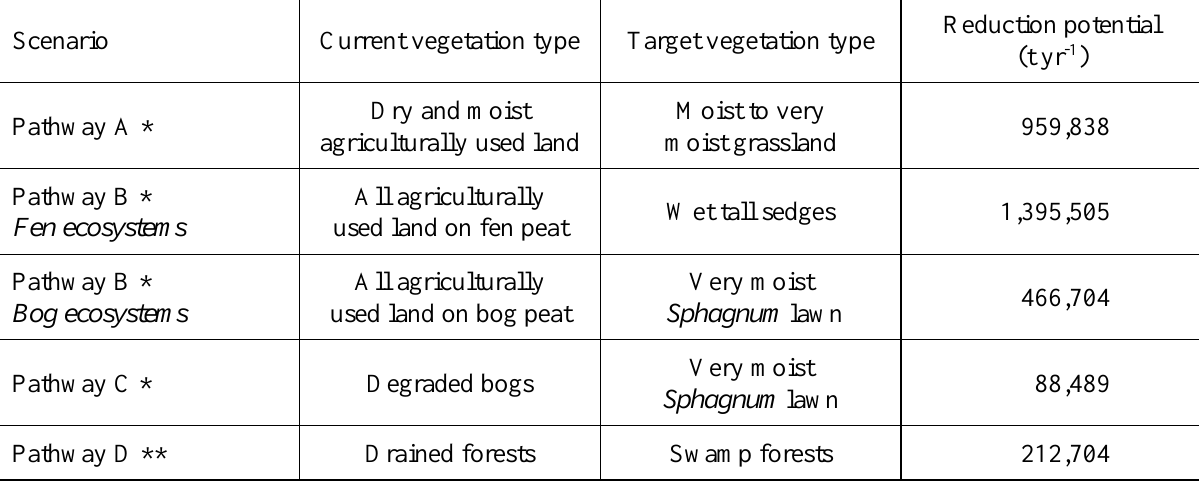
Table 3. CO -eq emission reduction potentials of the rewetting pathways A–D. The current and target 2 vegetation types are shown. The calculations of GWP reduction potentials follow * Hirschelmann et al . (2020) and ** Schrautzer et al .